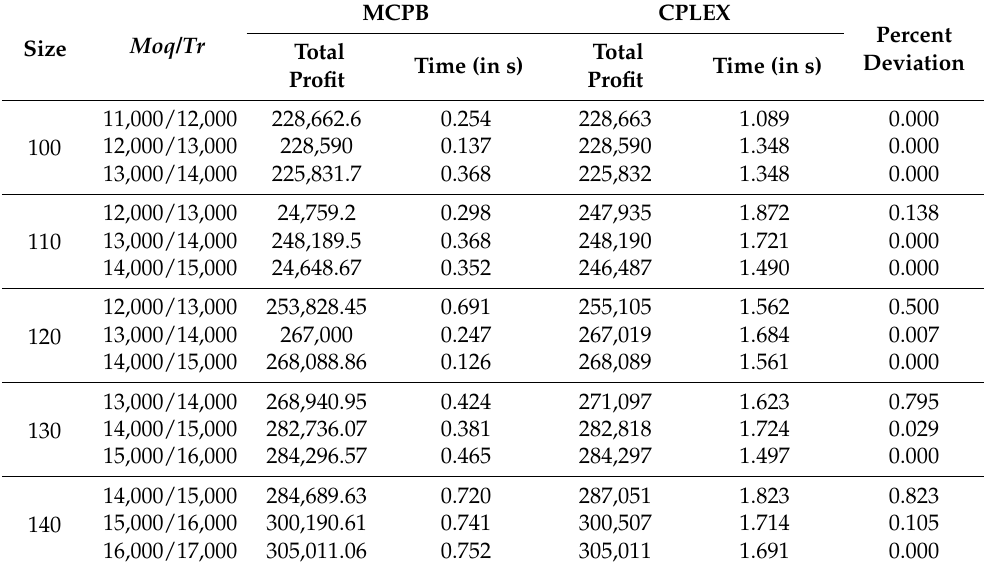
Table A2. The results of extended experiments on larger